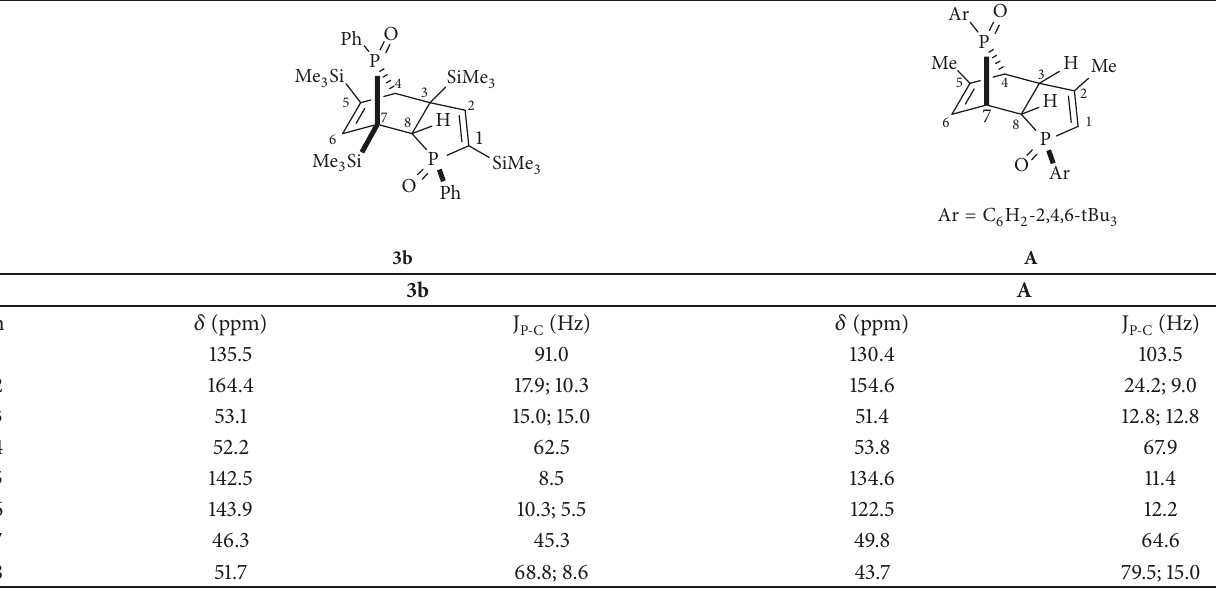
Table 2: Comparison of 13 C NMR chemical shifts (ppm) (CDCl 3 ) of 3b and A